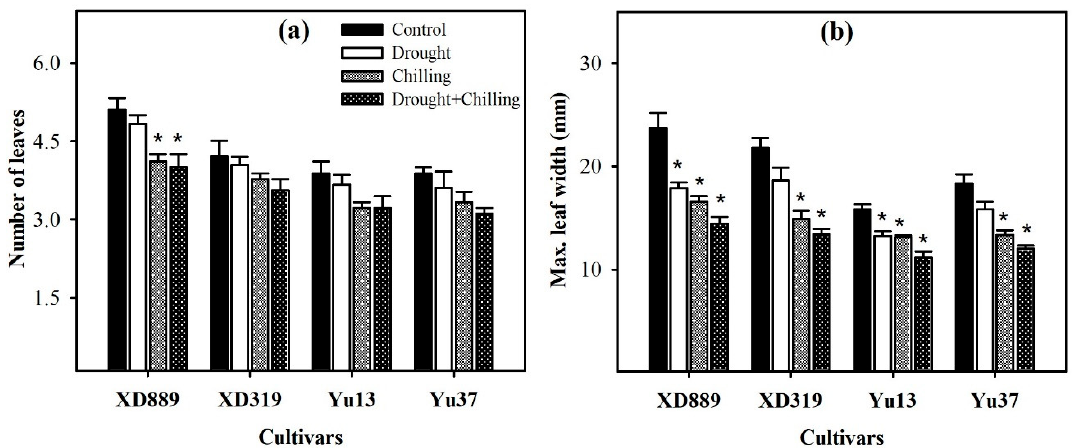
Figure 3. Number of leaves ( a ) and maximum leaf width ( b ) of four maize cultivars as influenced by the drought, chilling, and drought + chilling stresses. Vertical bars above mean indicate standard error of three replicates. Mean value for each treatment with * indicate significant differences compared with control according to LSD test ( P ≤ 0.05).